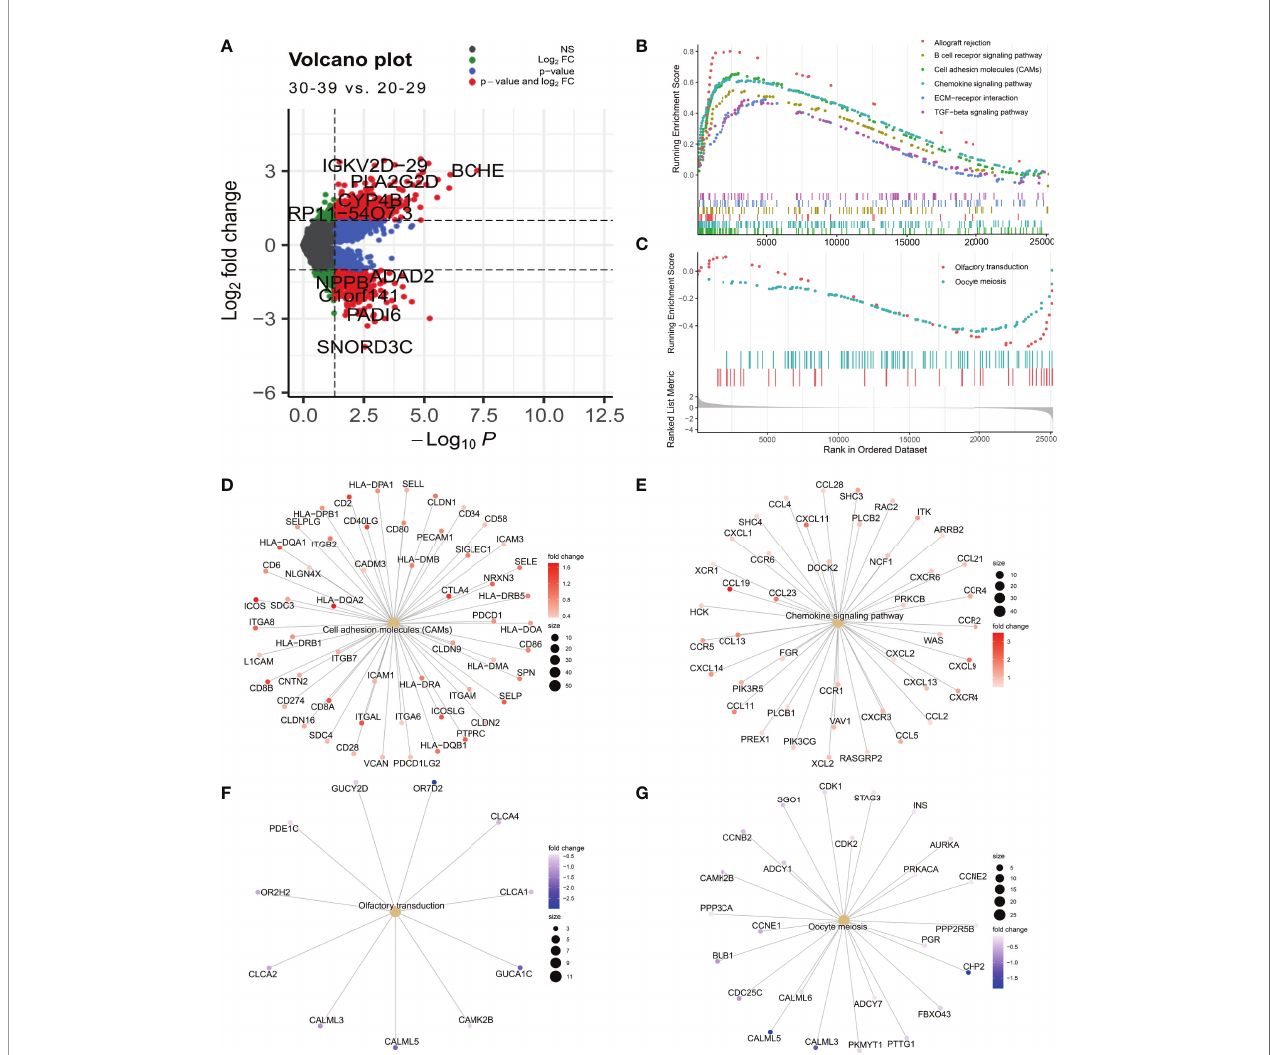
FIGURE 5 | Differential expression analysis of the 0-29 age group and the 30-39 age group. (A) Differential expression volcano plot (B) Signaling pathways enriched in the 30-39 age group (C) Signaling pathways enriched in the 20-29 age group. (D) Cell adhesion moleculars (CAMs) coregulated genes. (E) Chemokine signaling pathway coregulated gene. (F) Olfactory transduction coregulator gene (G) Oocyte meiosis coregulator